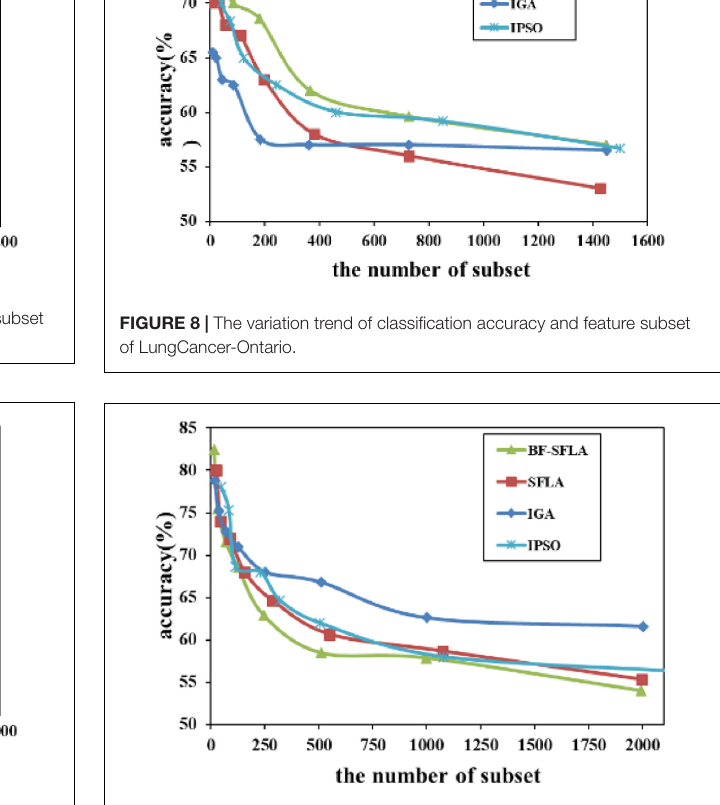
FIGURE 6 | The variation trend of classification accuracy and feature subset e of DLBCL-Outcome.